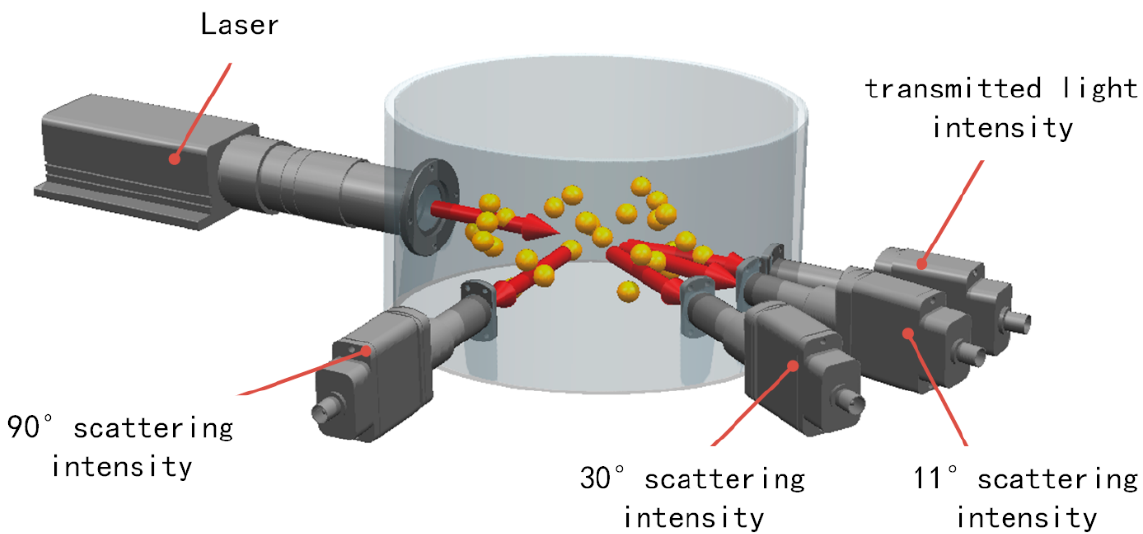
Figure 1. Multi-angle scattering principle prototype schematic diagram (out of proportion).